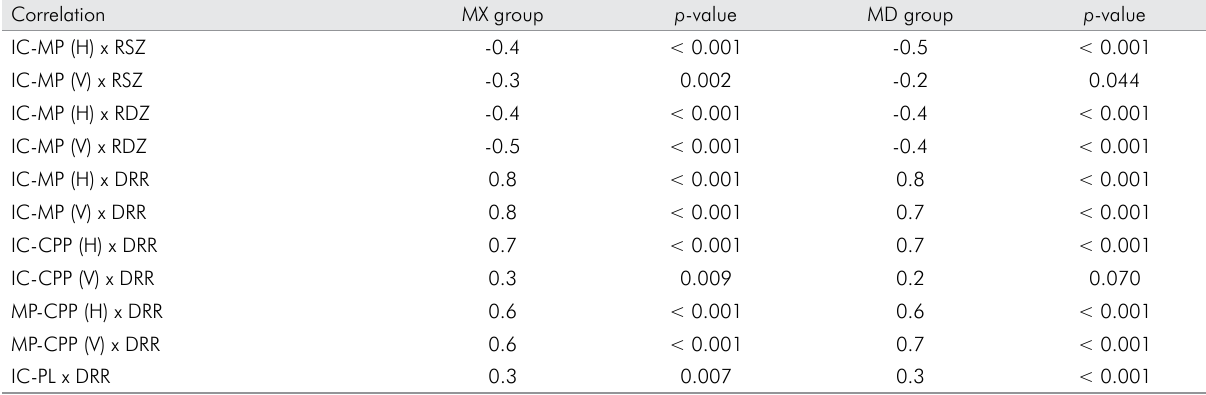
Table 3. Correlation of anatomical points and thickness of the remaining root dentin in the safety zone (RSZ), danger zone (RDZ), and area of dentin removal in the root (DRR) in the vertical (V) and horizontal (H) directions.